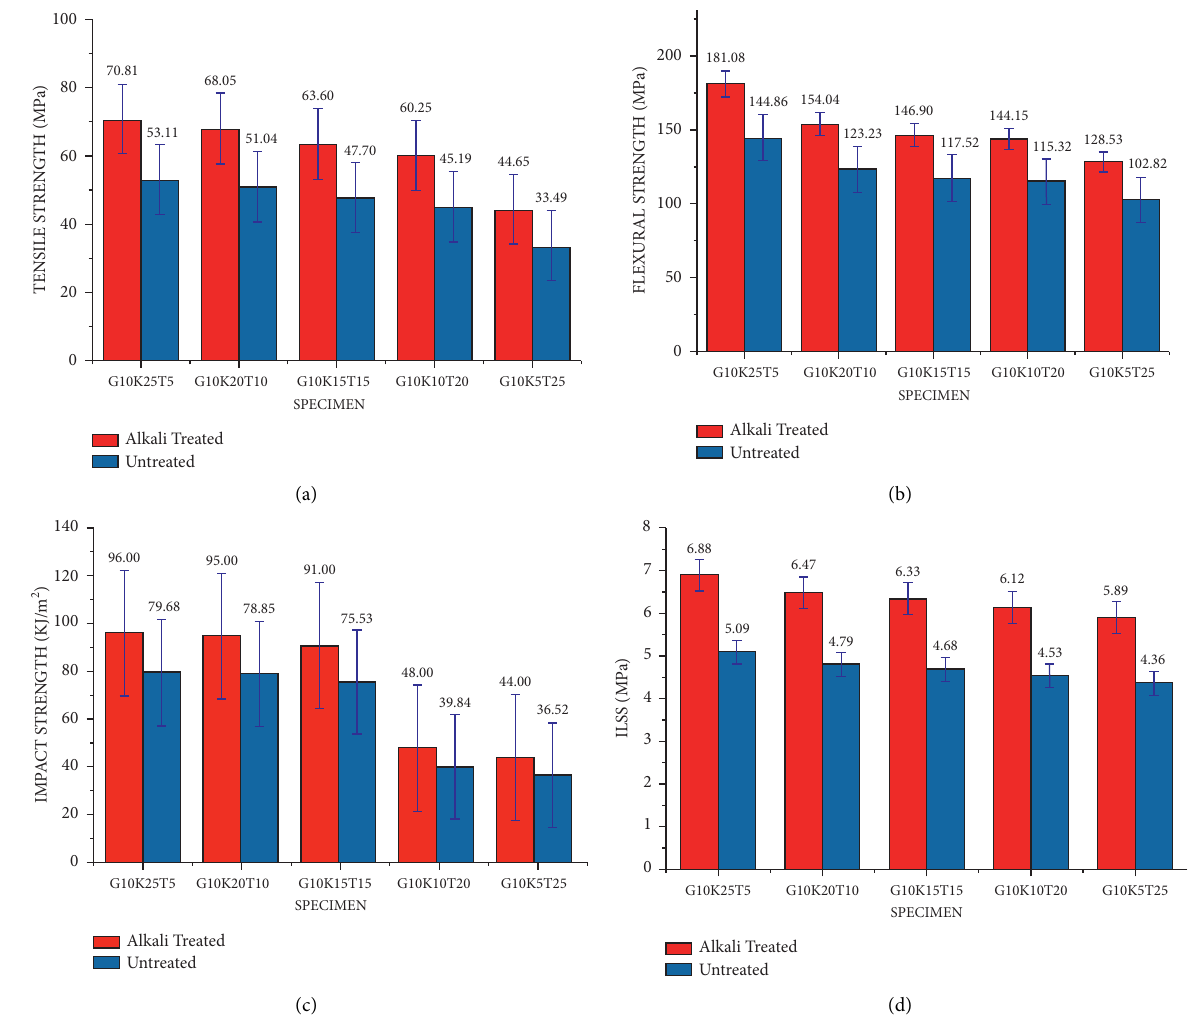
Figure 3: Tensile, flexural, impact, and interlaminar shear strength of glass/kenaf/tea leaf fiber-reinforced hybrid composites: effect of 5% NaOH alkaline treatment